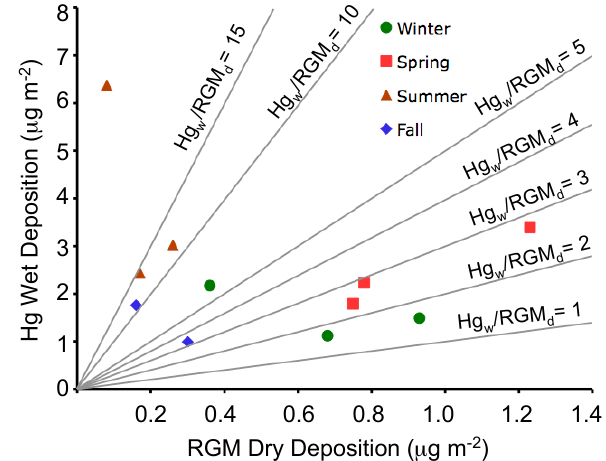
Fig. 6. Seasonal Hg wet deposition fluxes and estimated R GM dry deposition fluxes at TF. Contour lines represent wet to dry deposi- tion (Hg w /RGM d )